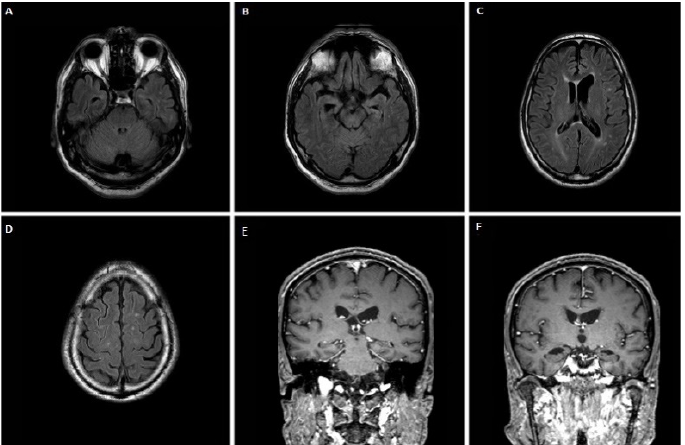
Figure 5. Brain MRI of case 5. Axial FLAIR images ( A – D ) and coronal T1 images ( E , F ) reveal mild frontal lobe atrophy.